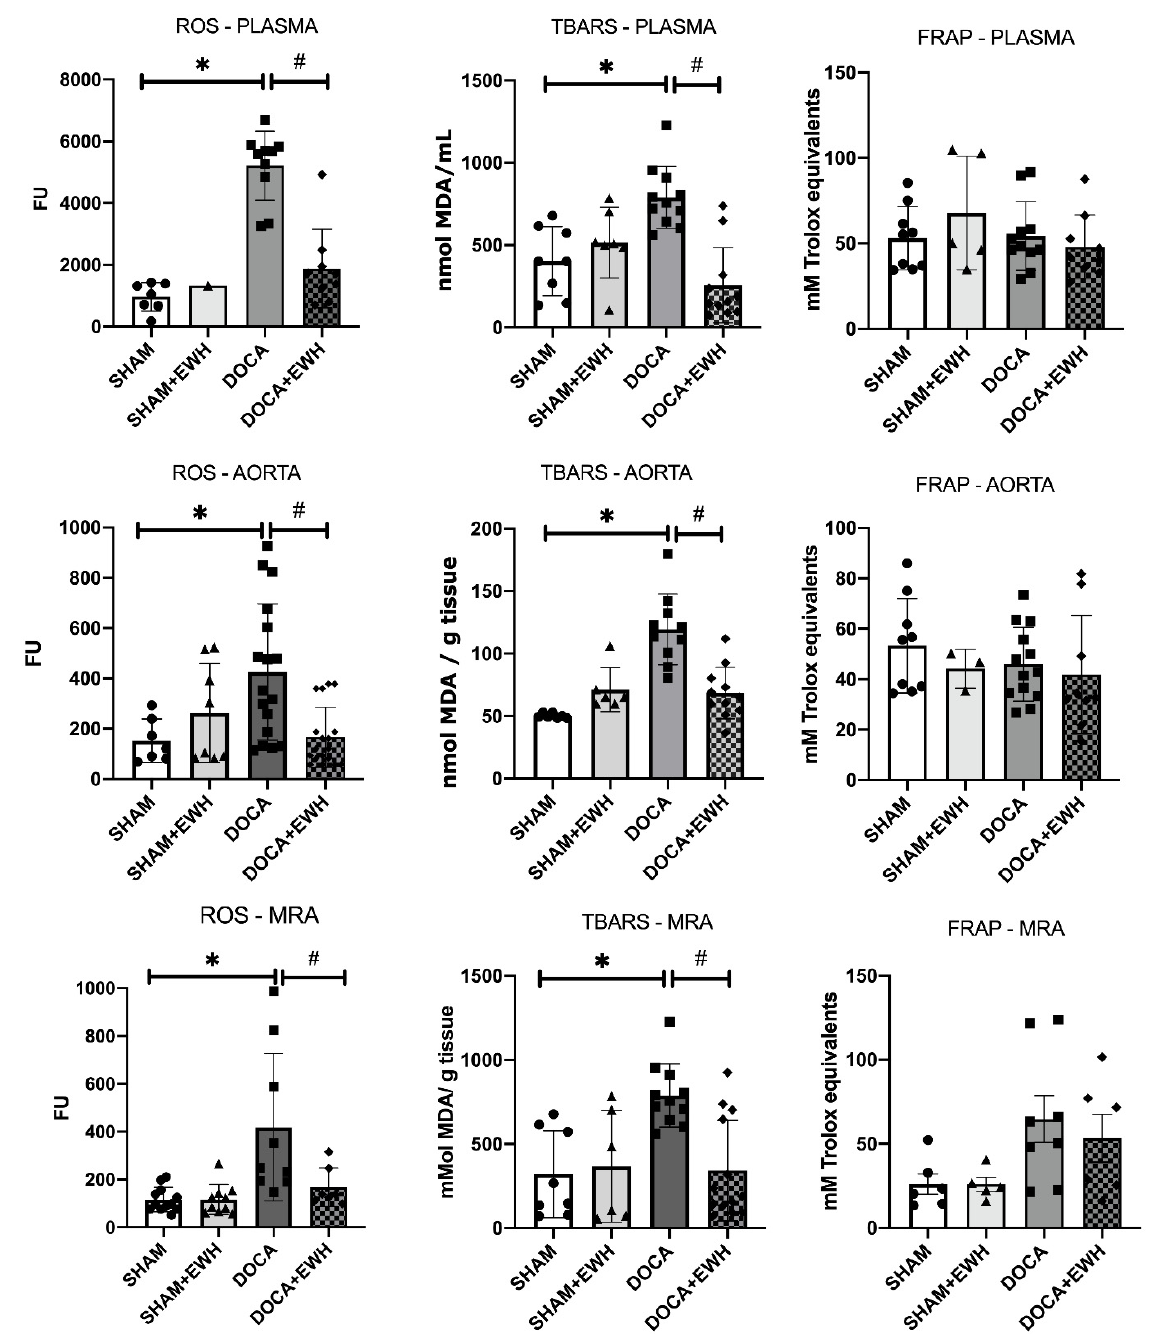
Figure 10. Effects of EWH on the oxidative stress (ROS and TBARS) and antioxidant (FRAP) capacity in plasma, MRA, and aorta of DOCA-salt rats. ROS, TBARS, and FRAP values were assessed in plasma, MRA, and aorta of SHAM, SHAM+EWH, DOCA, and DOCA+EWH rats. The results are expressed as mean ± SEM, and the number of animals is indicated as dots in the bars. Two-way ANOVA followed by Bonferroni post-test: p < 0.05 * vs. SHAM; # vs. DOCA.